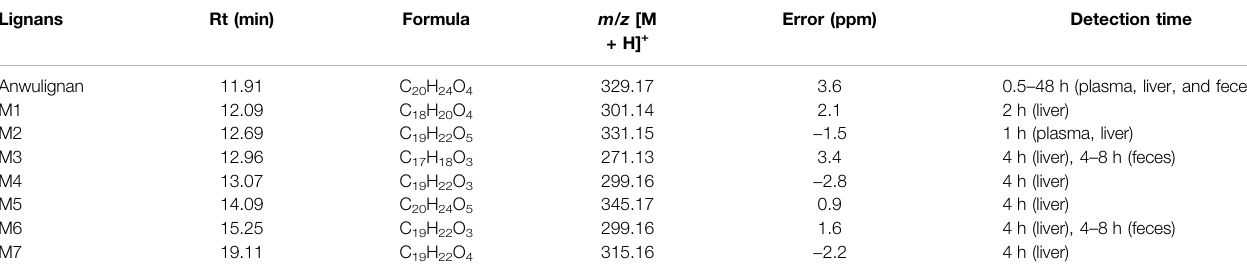
TABLE 6 | Characterization of anwulignan and identi fi ed metabolites by UHPLC-Q-Orbitrap-MS. Lignans Rt